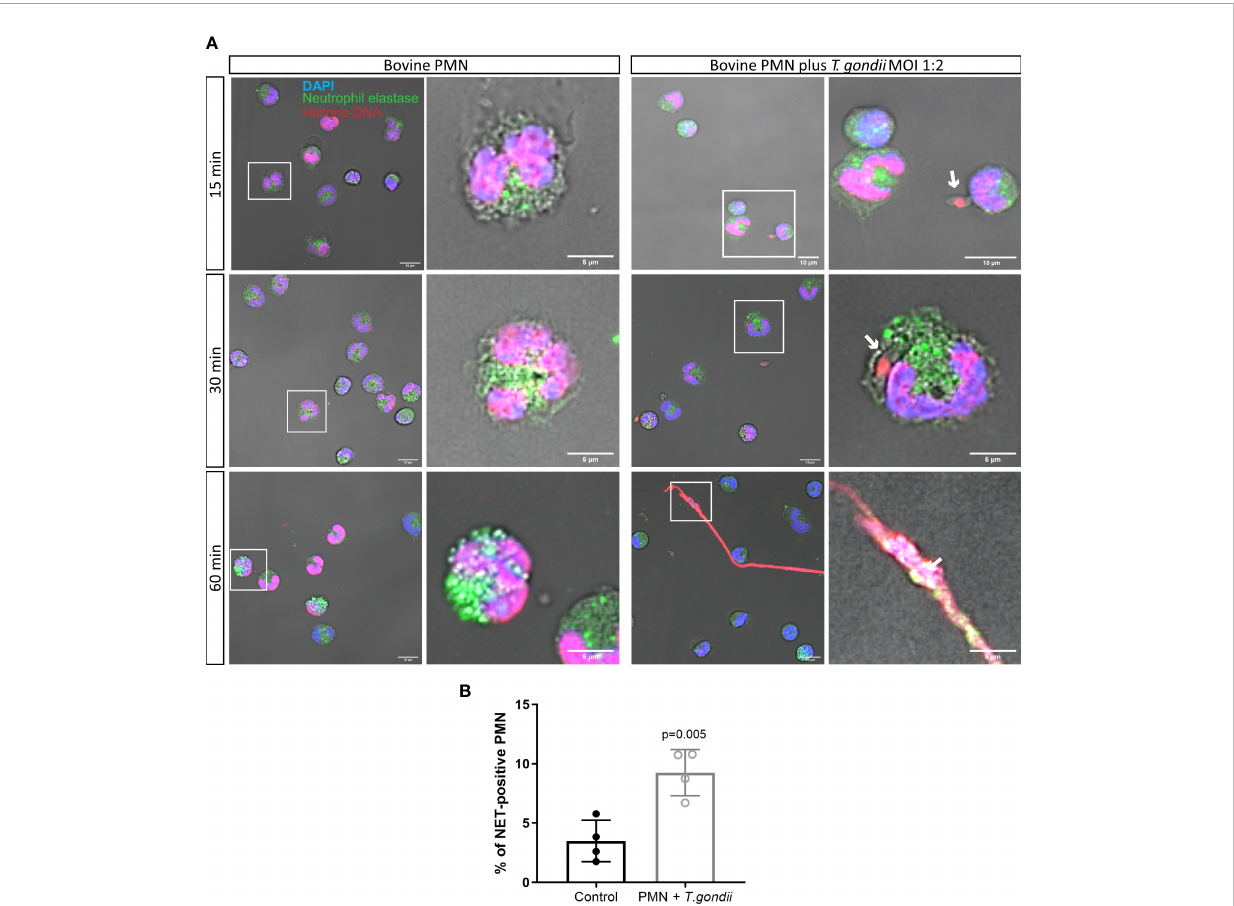
FIGURE 1 T. gondii -induced NET release in bovine PMN. 2 × 10 5 bovine PMN were confronted with vital 4 × 10 5 T. gondii tachyzoites (1:2 ratio) for 60 min. Samples were fi xed in PFA 4% after 15, 30 and 60 min of co-culture and the specimens were stained for neutrophil elastase (NE; green channel), histone-DNA complex (red channel) and DNA (blue channel) (A) . The percentage of cells releasing NETs was determined at 60 min of parasite confrontation as described in Material and Methods section and represented as bar graph (mean ± SD). White squares indicate the region of the image zoomed in the corresponding right panel. White arrows indicate T. gondii tachyzoites in direct contact with PMN or trapped on NETs. (B) . P -value was estimated by a Mann Whitney test ( a =